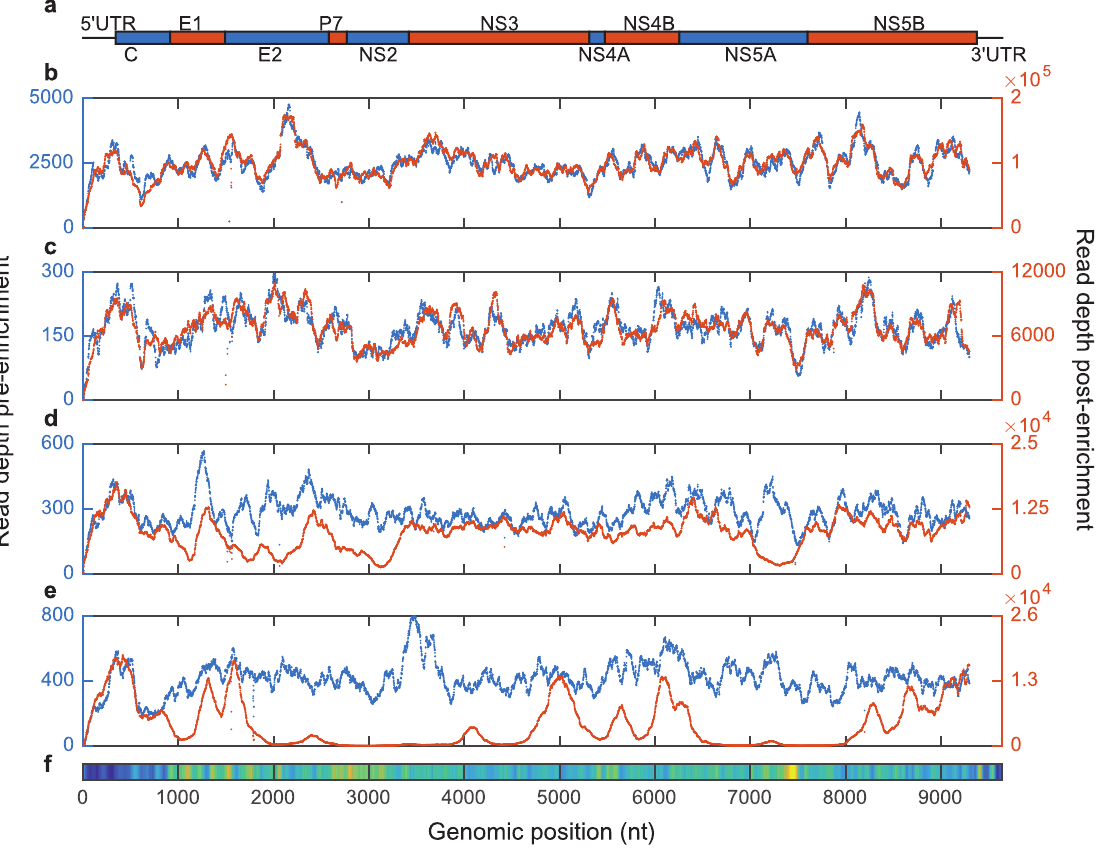
Figure 2. Enrichment efficiency decreases with phylogenetic distance. Read depth across the genome before (blue, left axis) and after (red, right axis) enrichment with a single-sequence subtype 1a probe set. a . The HCV genome comprises 5’ and 3’ untranslated regions (UTRs) and a large central segment encoding a single polyprotein that is cleaved into ten proteins. b . A subtype 1a sample enriched with probes derived from its own consensus sequence yields coverage patterns across the genome essentially identical to metagenomic sequencing. c . A distinct subtype 1a sample produces highly similar but non-identical patterns of pre- and post-enrichment genomic coverage. d . A subtype 1b sample yields low read depths at loci that are relatively divergent from the 1a probe sequence (E1, E2, NS2 and NS5a). e . Sequence capture of a sample from a different genotype, 3a, is poor across large segments of the genome. f . Heat map representing average diversity (calculated as Shannon entropy) among 165 HCV reference genomes. Nucleotide diversity varies dramatically across the genome and tracks drops in enrichment efficiency between phylogenetically distinct probe-target